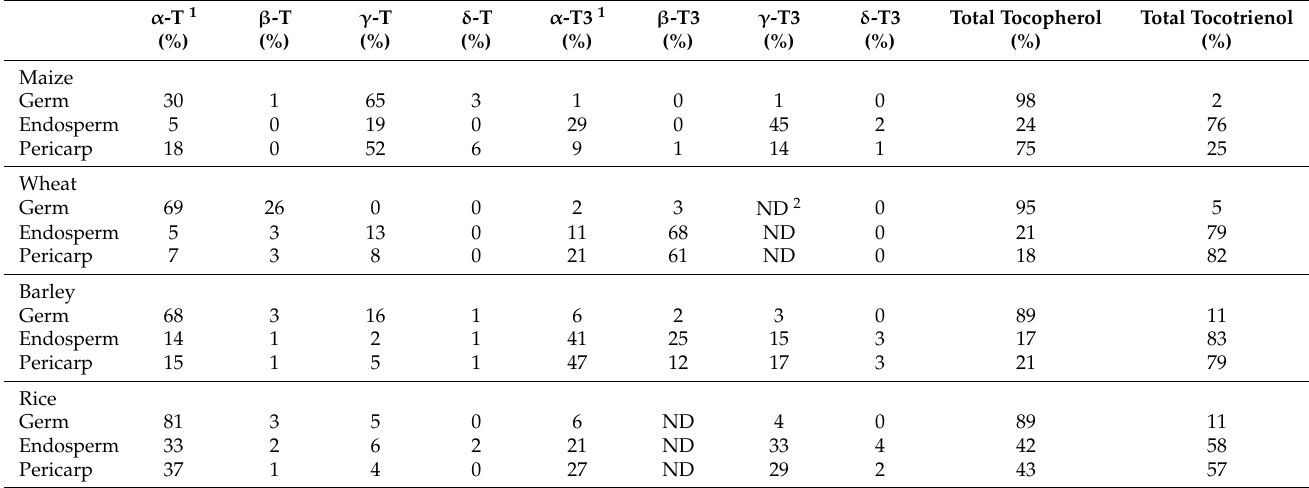
Table 2. Repartition of tocochromanols in the different parts of cereal